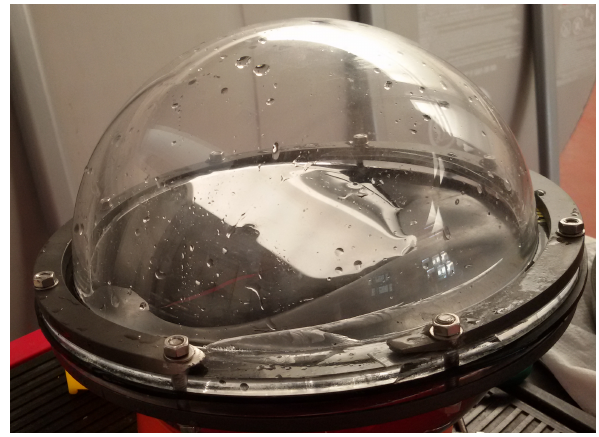
Figure 14. Check of breaking mode.